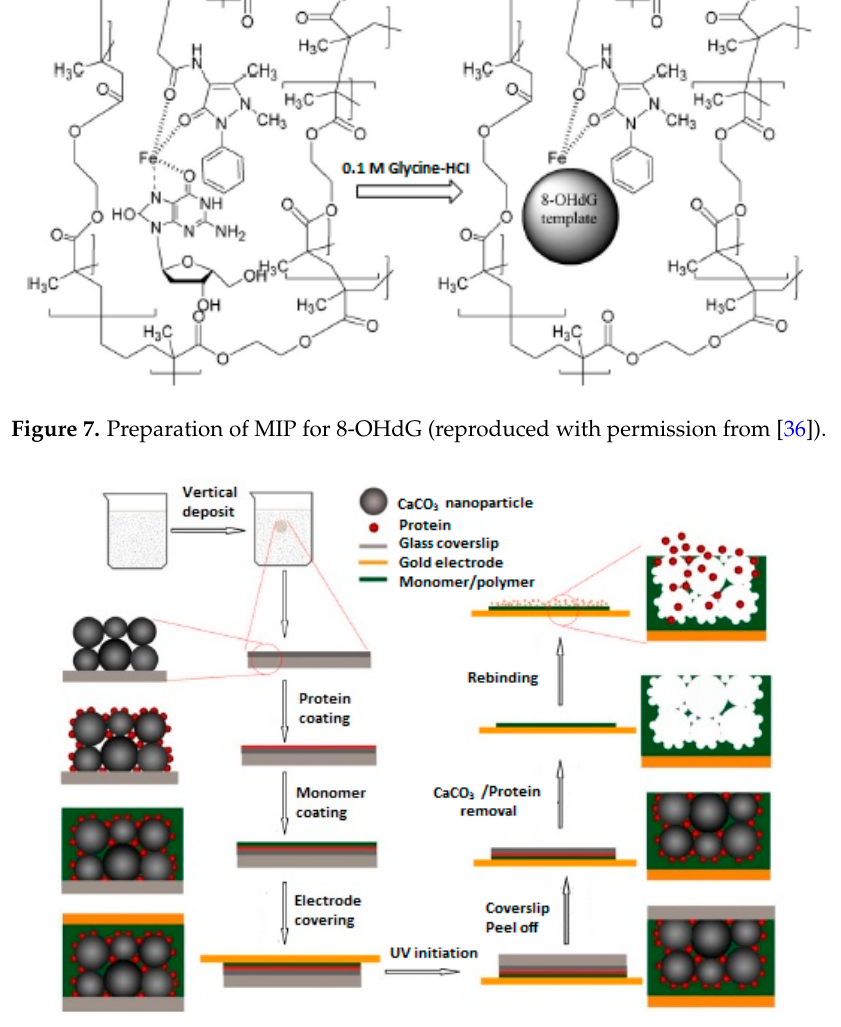
Figure 8. Preparation of QCM sensor toward lysozyme (reproduced with permission from [38]).